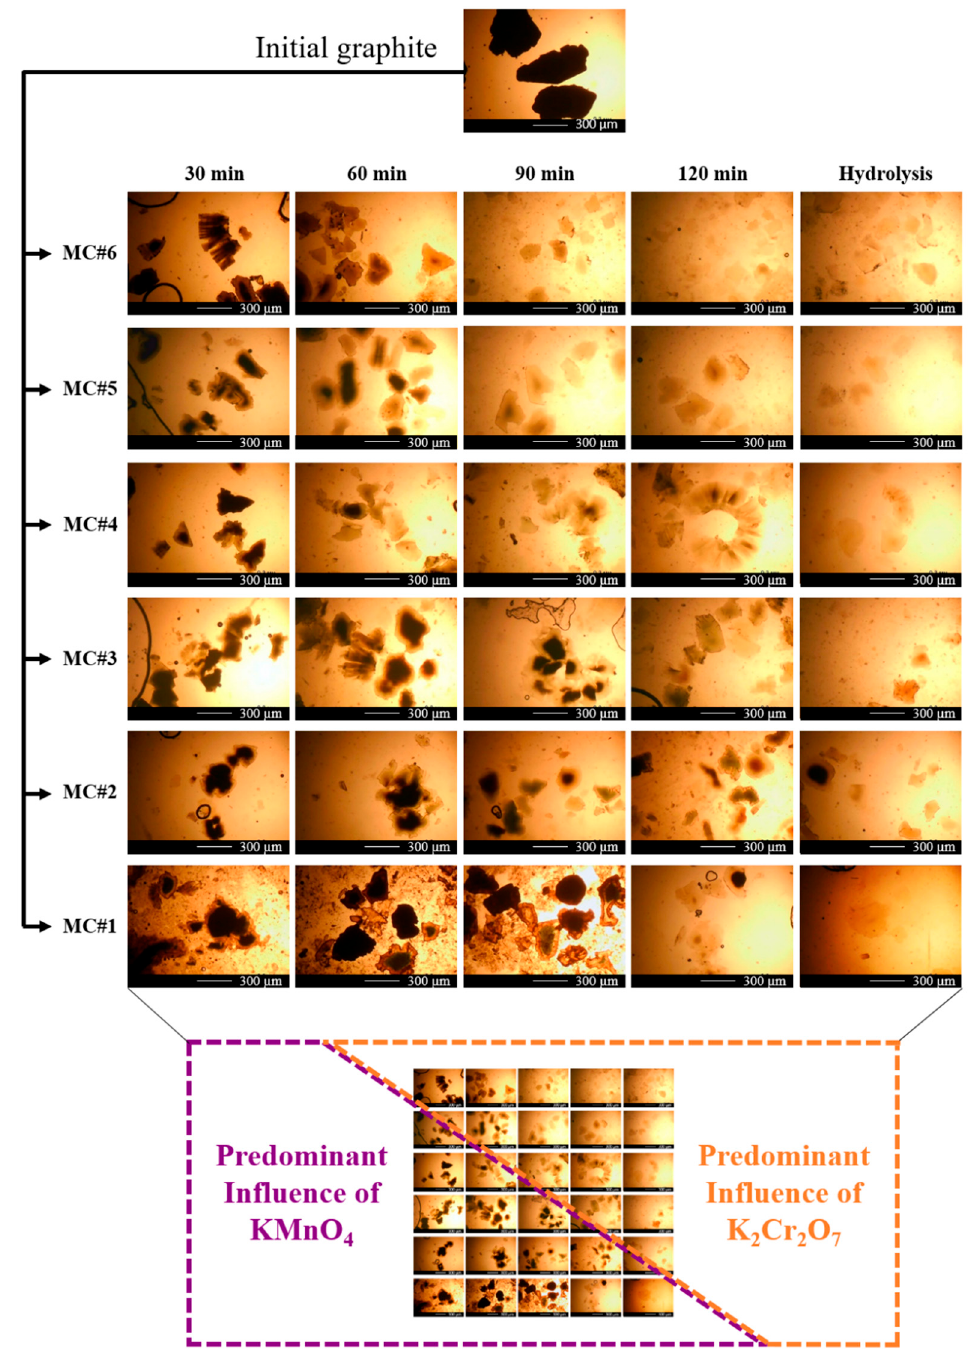
Figure 4. Optical images of the MC#1–MC#6 GO synthesis process every 30 min during the 2 h of the reaction time, from the initial graphite in H 2 SO 4 to the final product before purification.